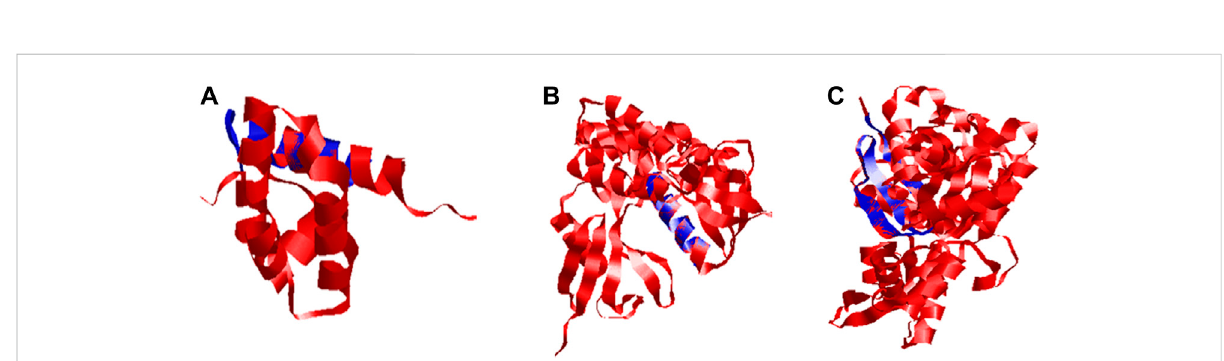
FIGURE 3 Superposed ribbon structure of predicted proteins models of Ds-DbRCaG-01-Rga2p, Ds-DbRCaG-03-Rga4p, and Ds-DbRCaG-05-Rga6p with their respective template regions. Blue indicates identi fi ed RGAs predicted proteins, while red indicates the template protein. (A) Ds-DbRCaG- 02-Rga2 superposed to model 1X6I, (B) Ds-DbRCaG-03-Rga4p superposed to model 1GC6, and (C) Ds-DbRCaG-05-Rga6p superposed to model